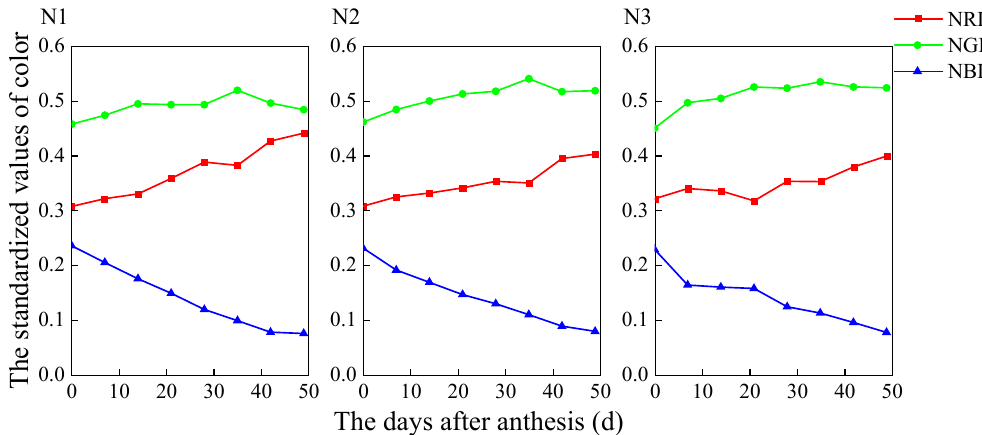
Figure 6. Dynamic changes in the standardized values of color for leaves with high, medium, or low nitrogen supplies in HD5 after anthesis.